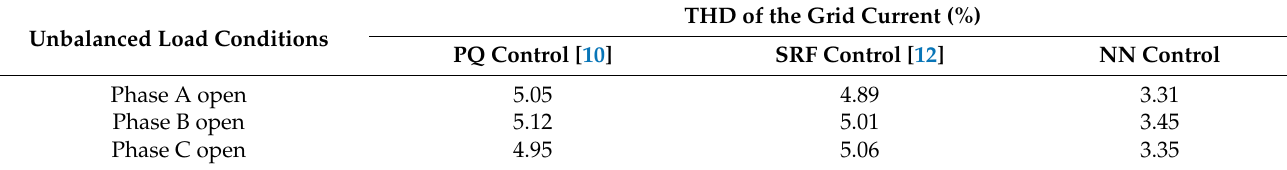
Table 4. Comparisons Grid current THD for NN controller with PQ and SRF control for various voltage unbalanced load